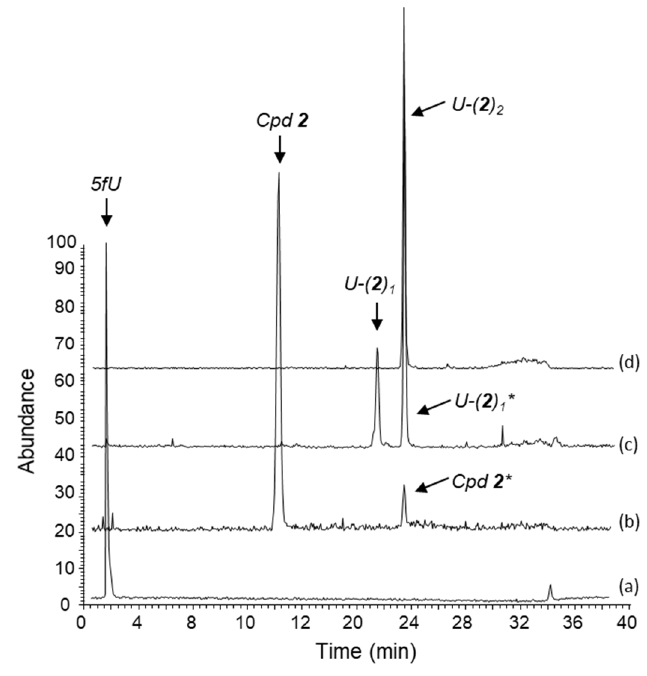
Figure 5. LC-HRMS analysis in negative mode [M-H] - of mixture obtained upon reaction of the two compounds 2 and 5-formyluracil (5fU) (0.5 mM each), at 37 °C for 180 min in a methanol:ammonium formate buffer 5 mM, pH 4.5 mixture (40:60, v:v). The mass/charge ratio were recorded as follows: ( a ) 138.50 < m/z < 139.50 corresponding to 5-fU with a retention time (rt) of 1.20 min, ( b ) 240.50 < m/z < 241.50 corresponding to compound 2 with a rt of 14.43 min, ( c ) 362.50 < m/z < 363.50 corresponding to the expected mono adduct U-( 2 ) 1 with a rt of 21.86 min, and ( d ) 604.50 < m/z < 605.50 corresponding to the bis-adduct U-( 2 ) 2 with a rt of 23.94 min. In panel ( c ) and in panel ( b ), an additional signal with a rt of 23.93 min are observed. Their correspond to the in source-fragmentation (ISF) of the bis-adduct during the electrospray ionization (ESI) process. The pics marked * (at rt = 23.90 min) refer to the ISF of U-( 2 ) 2 to generate both ion fragments analogous to U-( 2 ) 1 and the start-